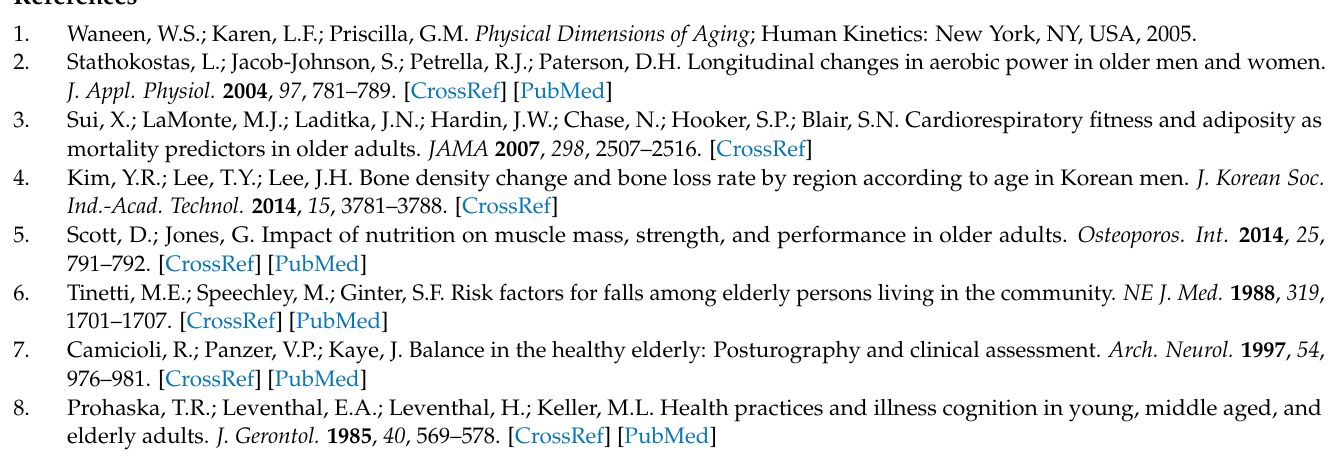
Figure A3. Correlations between age and lower extremity joint biomechanics upon running. ( a ) Ankle ROM, ( b ) knee ROM, ( c ) hip ROM, ( d ) ankle moment, ( e ) knee moment, ( f ) hip moment, ( g ) ankle power, ( h ) knee power, ( i ) hip power. * p < 0.05 indicates significant correlations between age and the variables.